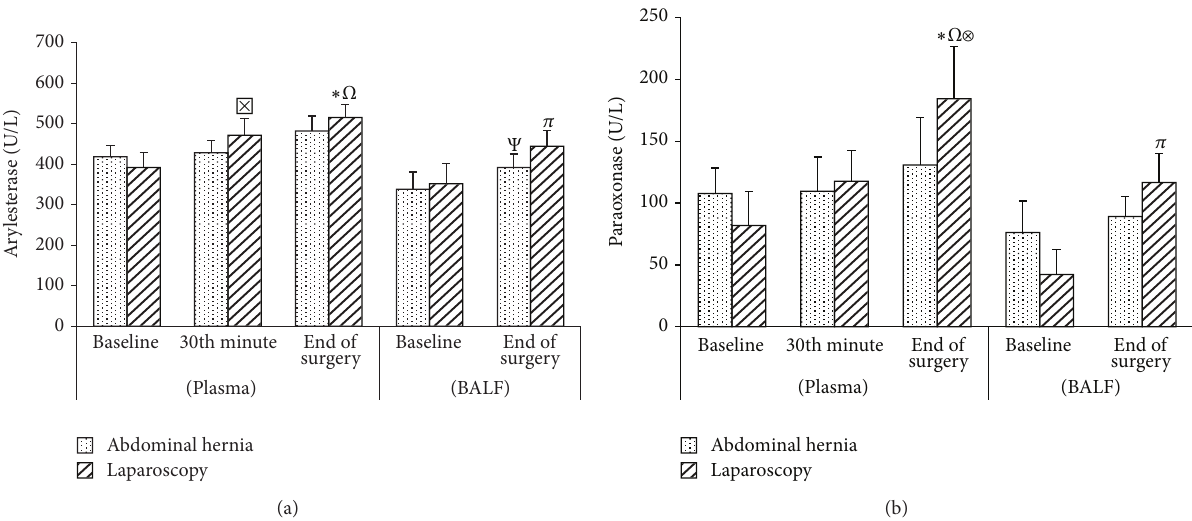
Figure 2: Pre- and perioperative ARES (arylesterase) (a) and PON (paraoxonase) levels (b) levels of the groups in plasma and BALF. Data are expressed as mean ± standard error. ∗ 𝑃 < 0.001 compared to plasma baseline, Ω 𝑃 < 0.05 compared to 30th minute, Ψ 𝑃 < 0.05 compared to BALF baseline, 𝜋 𝑃 < 0.01 compared to BALF baseline, ⊠ 𝑃 < 0.001 compared to plasma baseline, ⊗ 𝑃 < 0.01 compared to laparoscopy versus abdominal wall hernia.